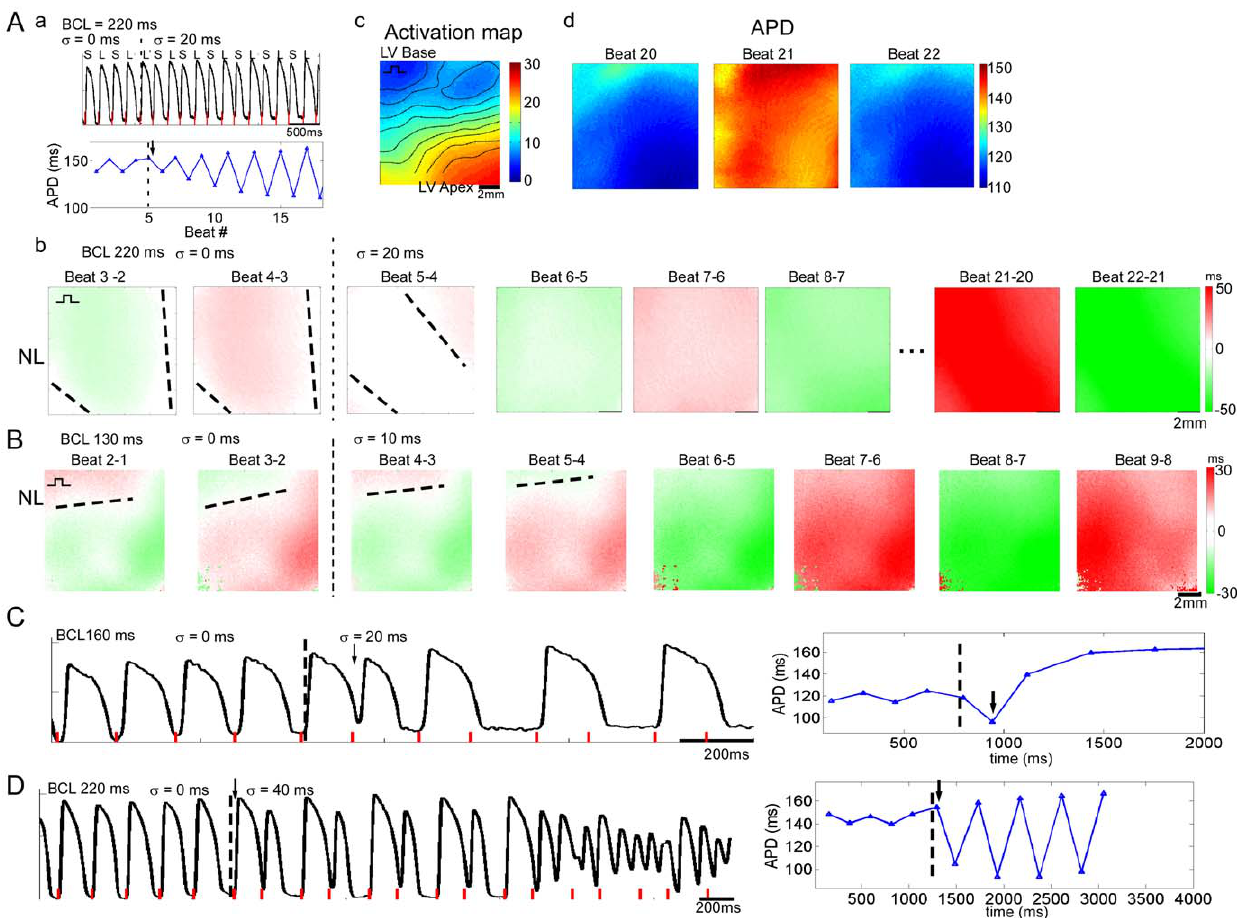
Figure 5. Cycle length oscillation in an isolated adult guinea pig heart. A. (a) V m and APD before and during CLO for BCL of 220 ms and s =20 ms. Phase reversal is indicated by the black arrow. (b) Successive APD alternans maps before and during CLO for low amplitude, spatially concordant alternans. Nodal lines (NL) are indicated by dashed lines. (c) Activation map. Pacing site near the left ventricular (LV) base indicated by square pulse symbol. (d) Successive APD maps after reaching steady-state. B. Successive APD alternans maps before and during CLO for spatially discordant alternans induced prior to CLO at BCL =180 ms. C, D. V m and APD before and during CLO that resulted in loss of 1:1 capture after several beats ( C ) and initiated ventricular fibrillation ( D ). Red lines indicate timing of stimuli. Recordings in A and D are from same isolated heart, and B and C are from a different heart. doi:10.1371/journal.pone.0040477.g005 Table 1. Summary of the transient response to CLO in different models.